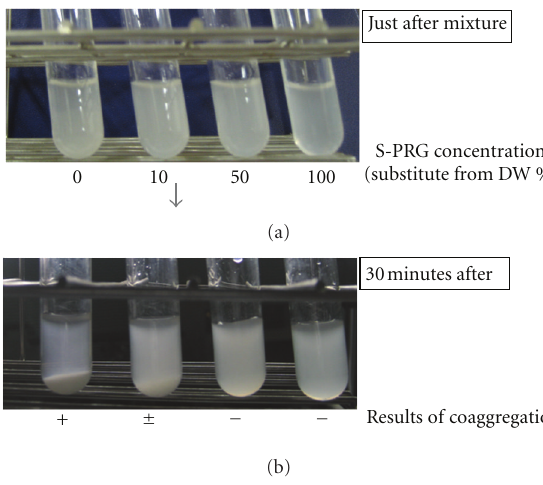
Figure 4: Coaggregation between P. gingivalis and F. nucleatum in the presence and absence of S-PRG eluate. (a): photographs of coag- gregation. (b): results of coaggregation